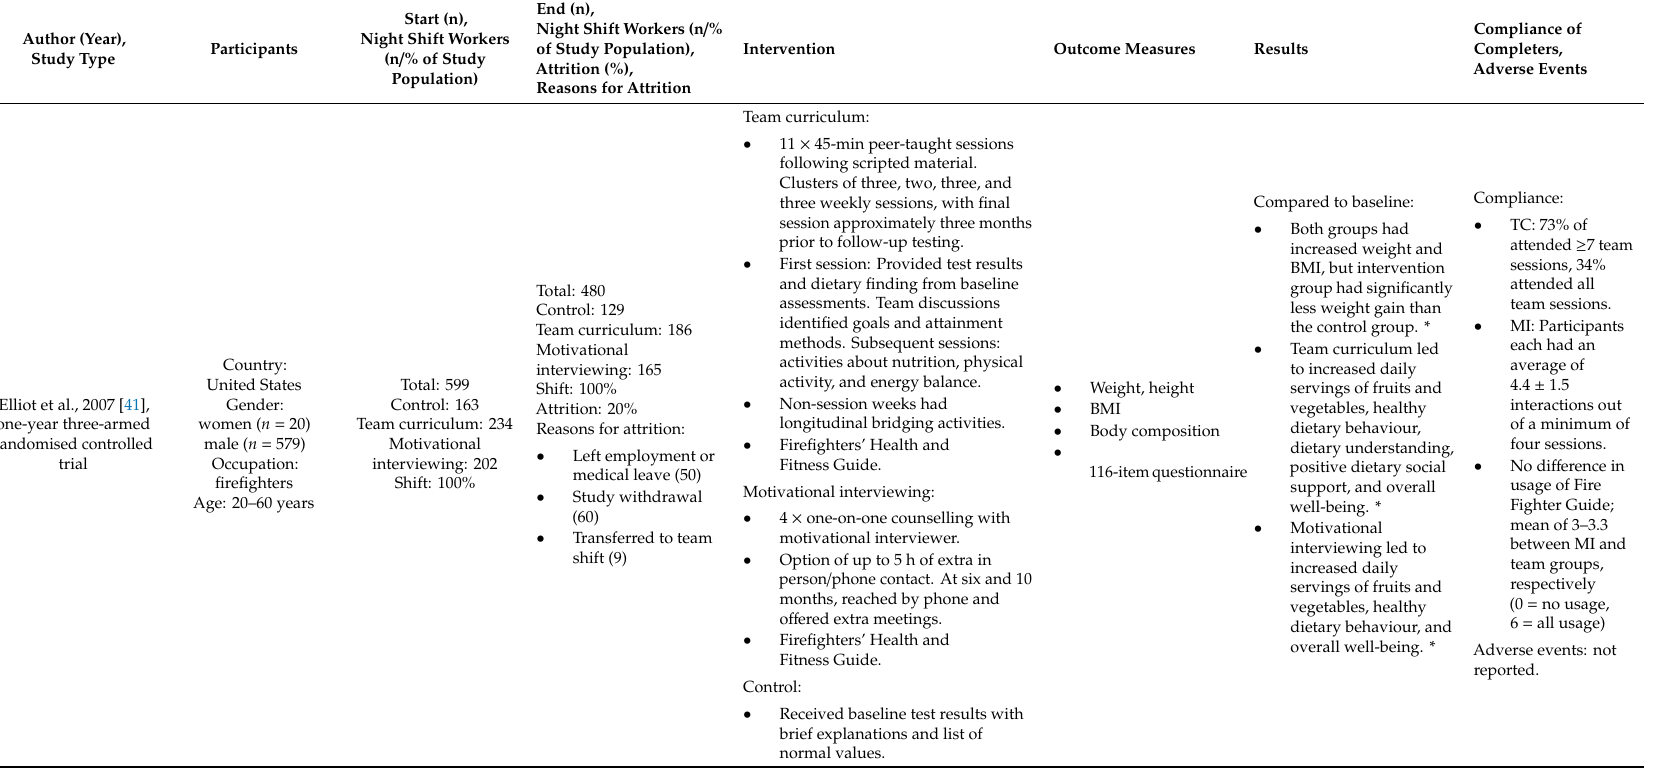
Outcome Measures Results